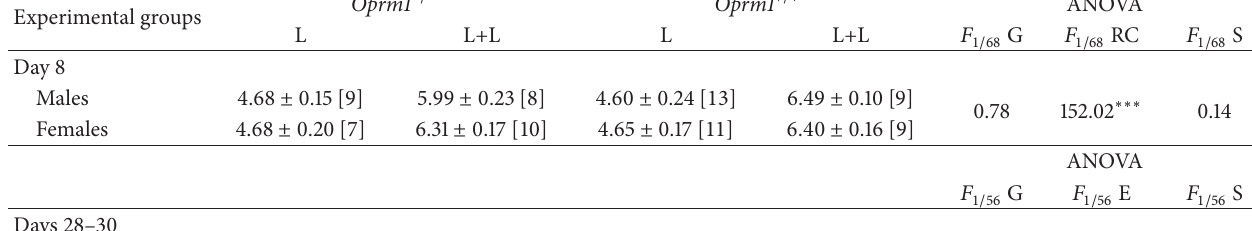
Table 1: Mean ( ± SEM) body weight (gr.) of mice (males and females) belonging to the four experimental groups. Experimental